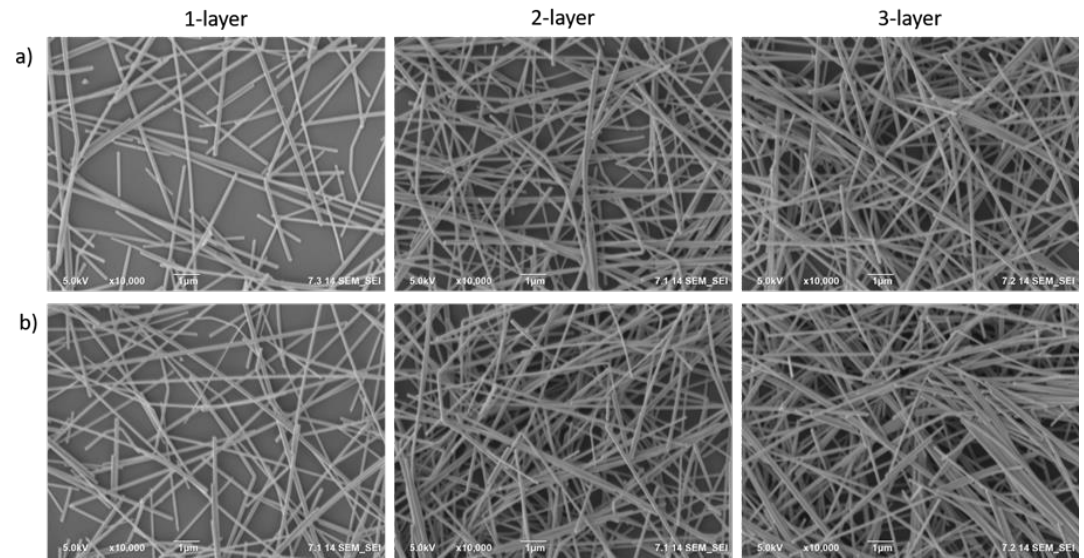
Figure 2. SEM images of 1-, 2-, and 3-layered AgNW films for ( a ) 3 h and ( b ) 12 h deposition time.